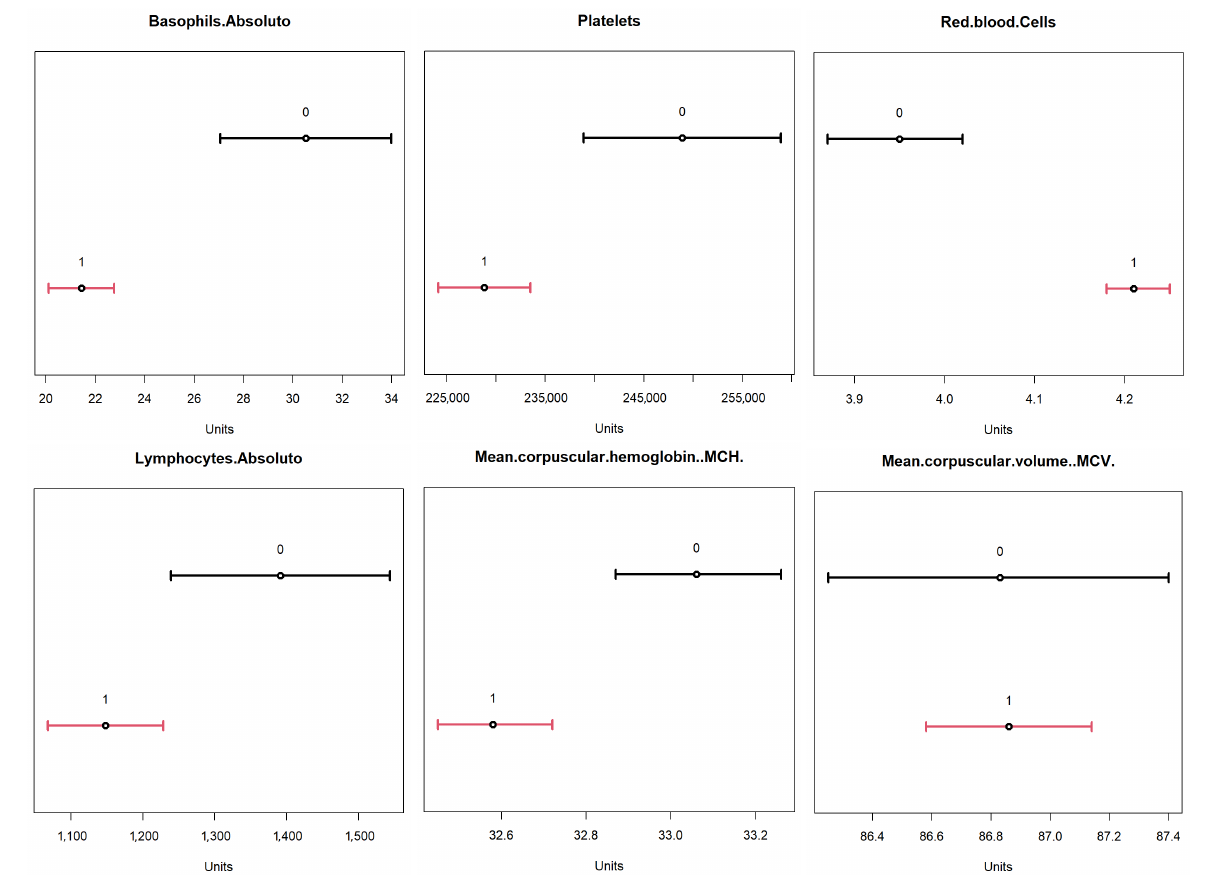
Figure 23. 95% confidence intervals of the variables identified at level 3— TESSOM